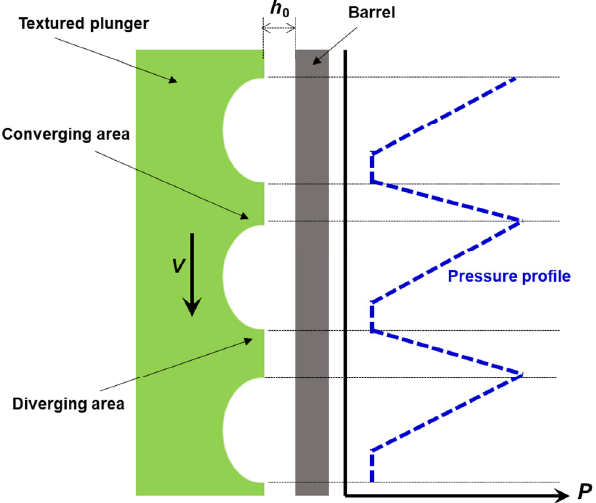
Fig. 7 Typical pressure distribution in plunger with spherical micro textured